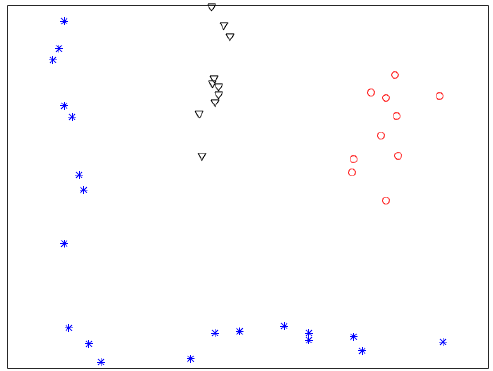
Figure 3. A clustering result of the dataset shown in Figure 1.